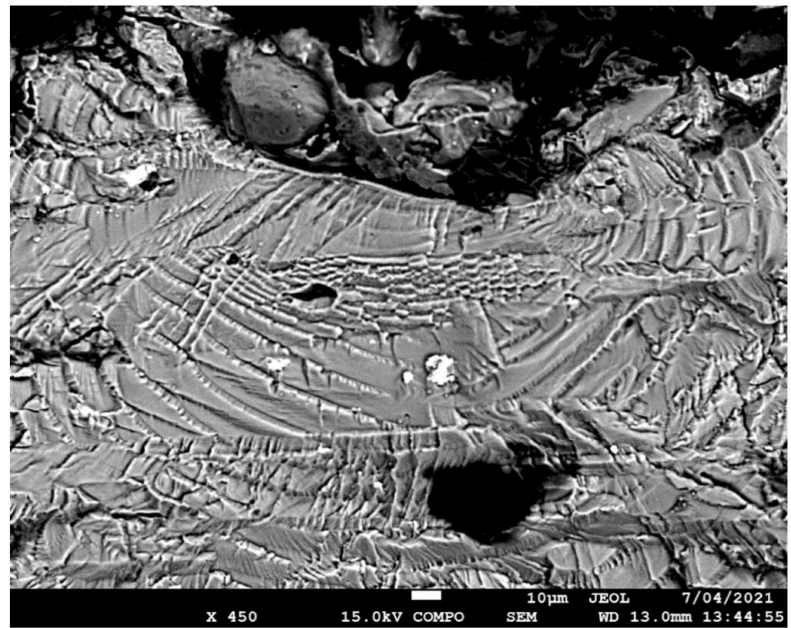
Figure 6. SEM of the lead crack (Crack 1) in specimen